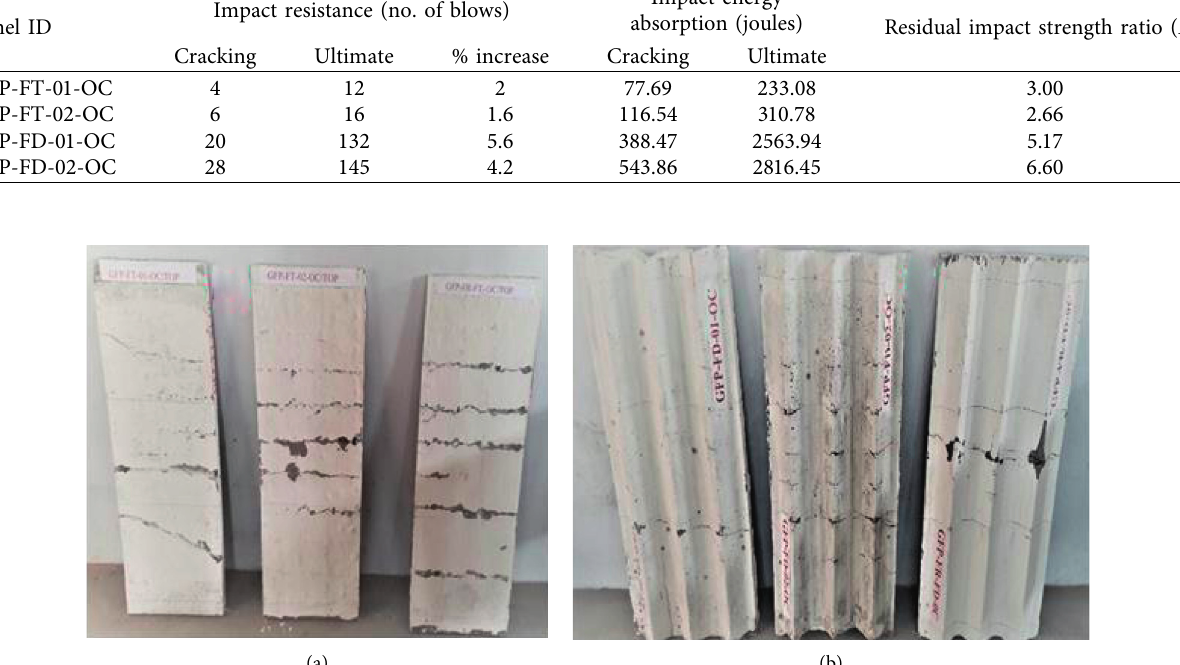
Figure 13: Cracking behavior of GF panels under flexure. (a) Flat panels. (b) Folded